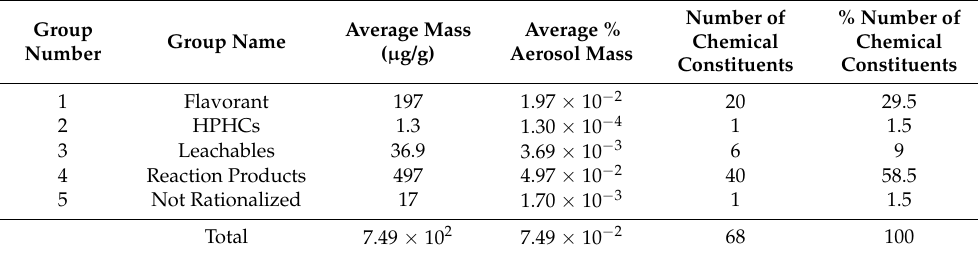
Table 4. Summary of non-targeted analyses of Me3 aerosol constituents detected by GC and/or LC NTA methods using the non-intense puffing